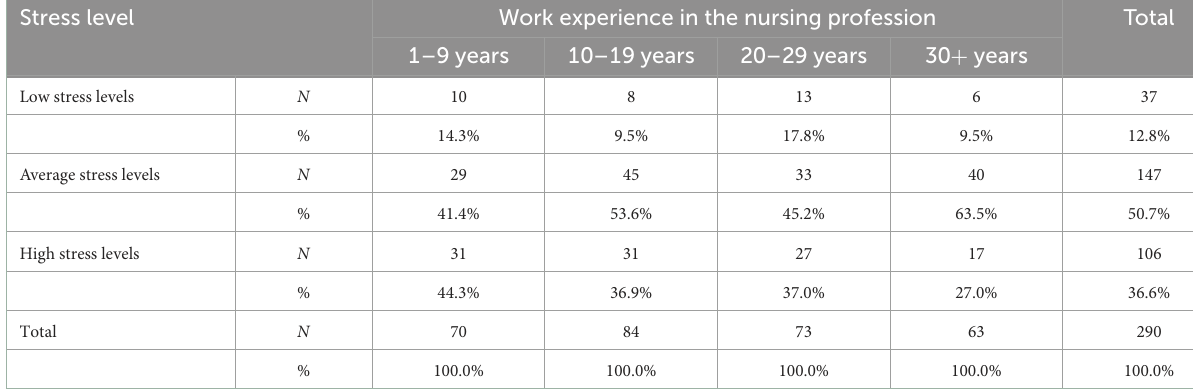
TABLE 3 Stress level and work experience in the nursing